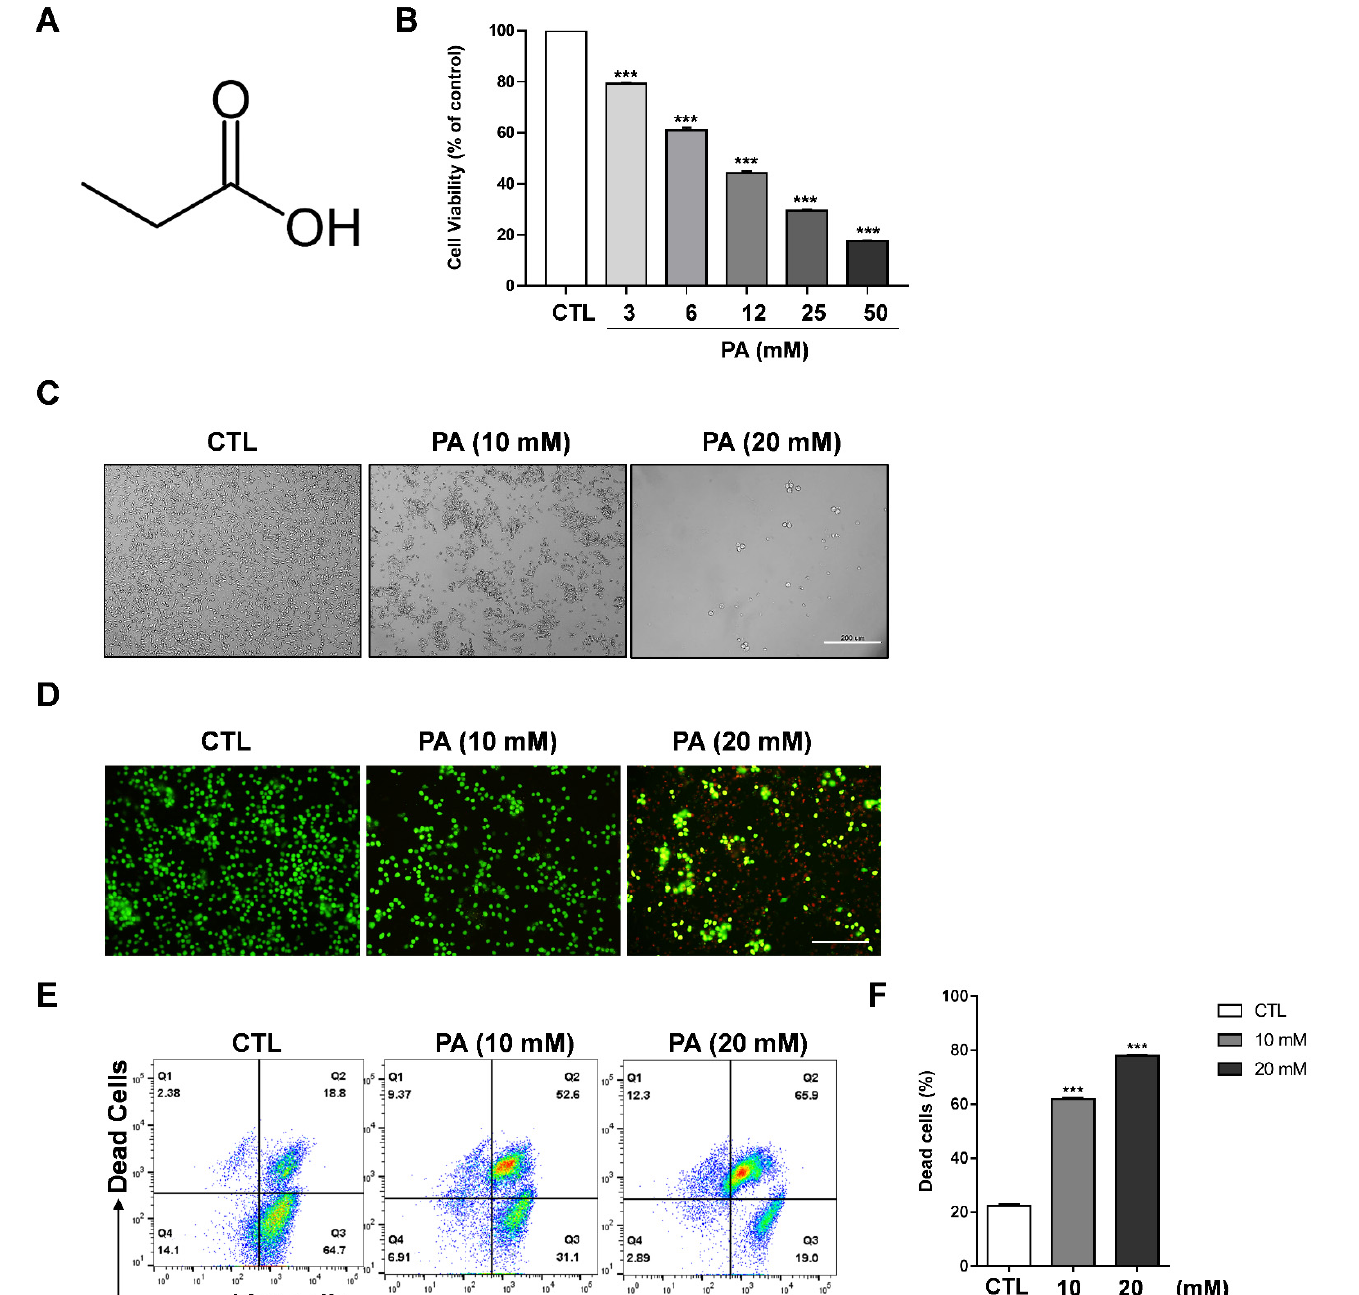
Figure 1. PA-induced cytotoxic effects on HeLa cells. ( A ) Structure of propionic acid. ( B ) Cell viability as measured through MTS assays. HeLa cells were exposed to various concentrations of PA. ( C ) Cell morphologies taken after 48 h of treatment with PA (scale bar: 200 µ m). ( D ) Live and dead assay performed following PA treatment of HeLa cells. The cells were stained with calcein AM and ethidium homodimer-1 and images were taken using a fluorescent microscope (scale bar: 200 µ m). ( E ) Assessment of the live and dead assay using a flow cytometer. ( F ) Quantification of dead cells. Values indicate means ± SEM. ( n = 3, *** p ≤ 0.001).